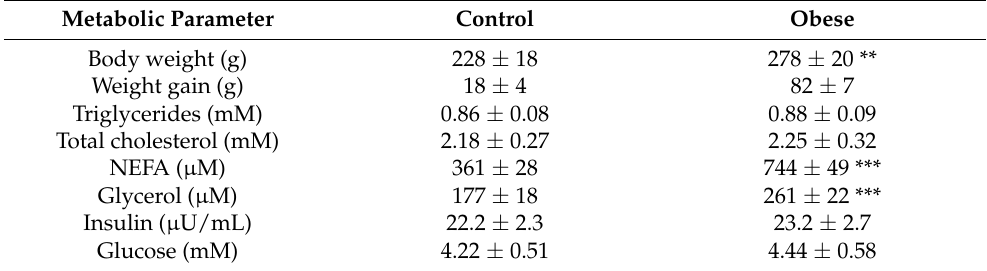
Table 1. Effect of obesity on metabolic parameters, H 2 S and polysulfide production in adipose tissue. Metabolic Parameter Control Obese